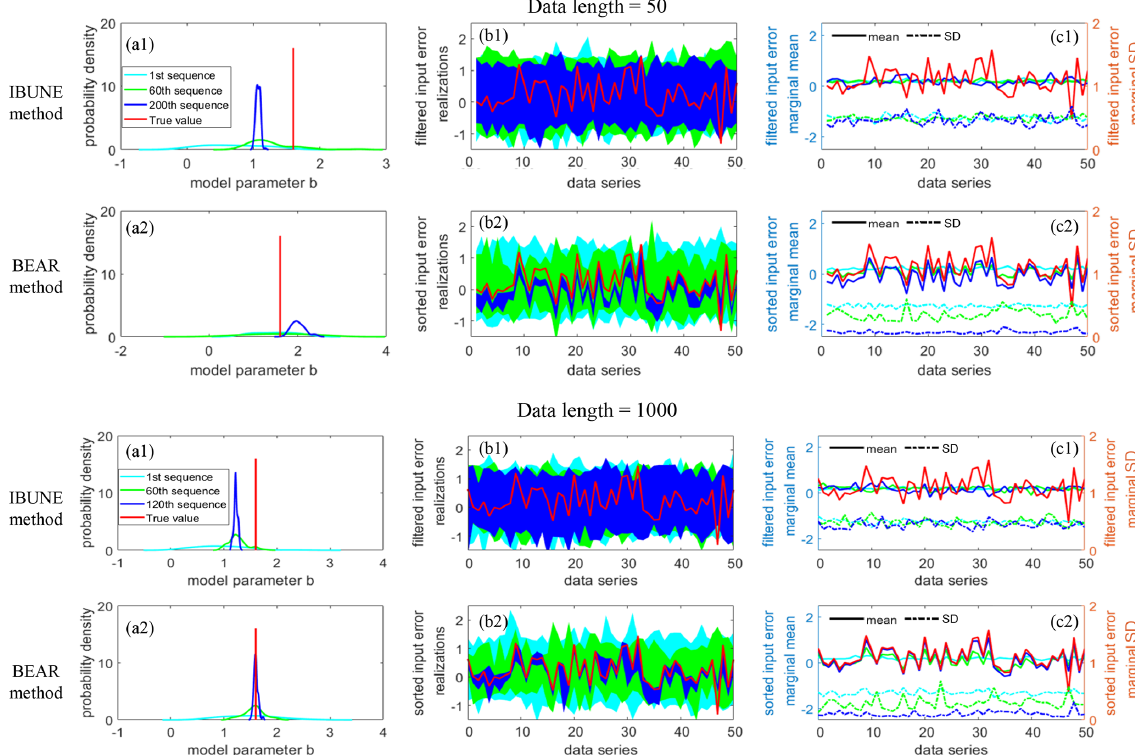
Figure 5. Comparison of the results for scenario 1 in synthetic case 1 and the ensemble particle size of N = 100 at different sequences of the calibration (represented with different colors), via different methods (row 1 – IBUNE method; row 2 – BEAR method), and under different data lengths in the calibration (in the upper group, the data length is 50; in the lower group, the data length is 1000, and 50 data points that are the same as the upper group are selected and shown). Panels (a1–a2) show the probability density of the model parameter b at different sequences of the calibration. The other model parameters have the same pattern of change, and thus, there is no need to show them. Panels (b1–b2) show the value interval of the input error realizations of 100 particles after reordering in the BEAR method or filtering in the IBUNE method. Panels (c1–c2) show the corresponding marginal mean and standard deviations at each time step. The first sequence (in cyan) shows the raw input errors of random sampling before reordering or